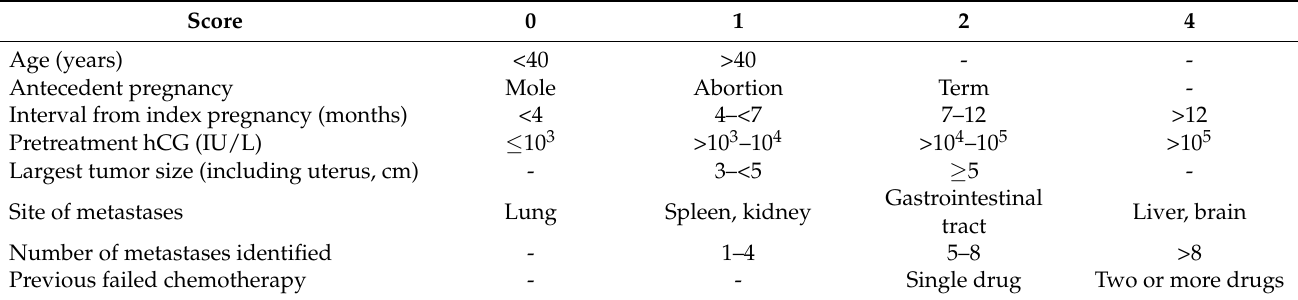
Table 2. WHO scoring system based on prognostic factors modified as FIGO